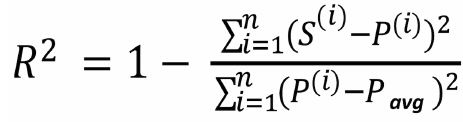
Figure 2. R 2 equation where i=1 to n observations evaluated. S (i) denotes the prediction for the i th observation using the simplified model, P (i) denotes the prediction for the ith observation using the ML model, and P avg denotes the average prediction from the ML